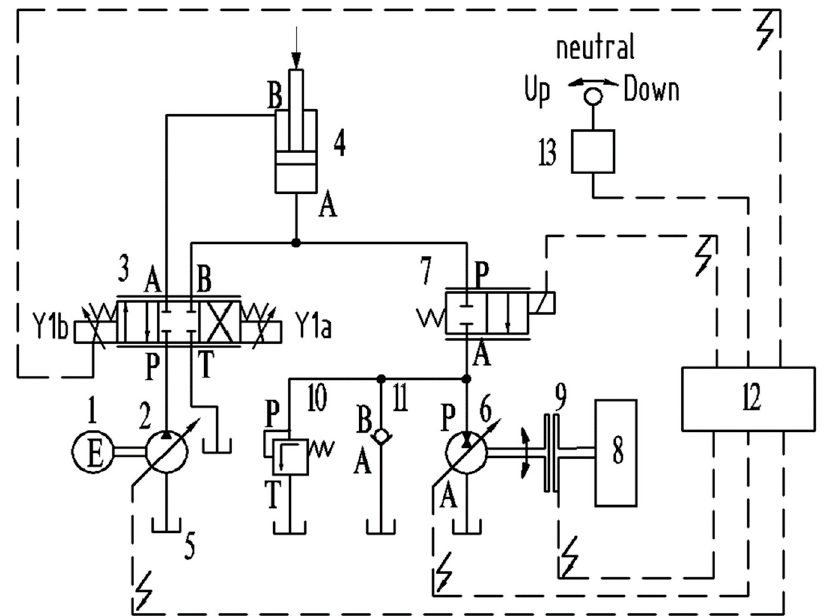
Figure 5. Configuration of the flywheel energy recovery system (FERS) for the hydraulic excavator (HE) boom: 1, engine; 2, pump; 3, directional control valve; 4, boom cylinder; 5, reservoir; 6, hydraulic pump motor; 7, 2/2 directional control valve; 8, flywheel; 9, clutch; 10, safety valve; 11, check valve; 12, controller; and 13, joystick.